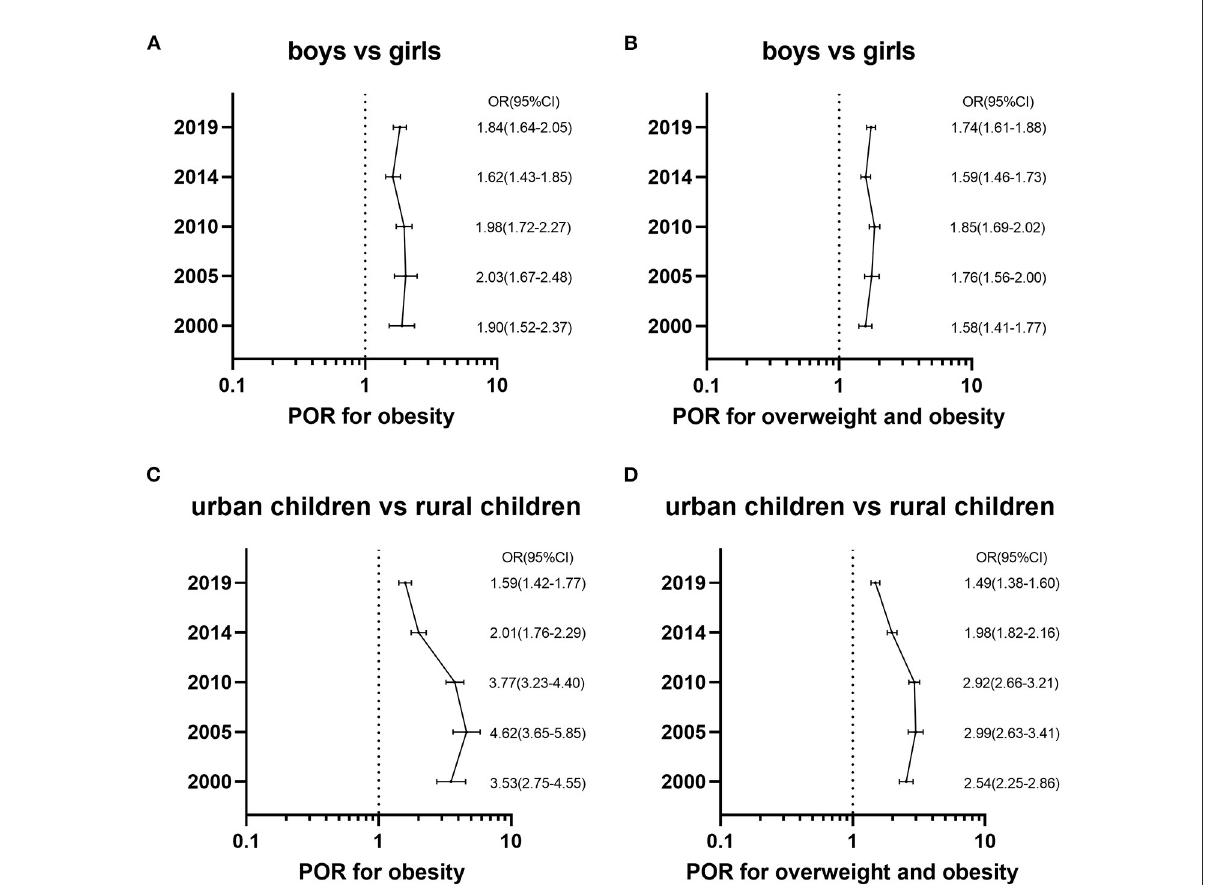
FIGURE3 The prevalence odds ratios (POR) and the 95% confidence intervals (CI) for overweight and obesity of boys vs. girls with adjustment for the region, location and age in different survey years and urban children vs. rural children with adjustment for the region, sex and age in different survey years. (A) Shows PORs for obesity of sex disparity by using WGOC standard. (B) Shows PORs for overweight and obesity combined of sex disparity by using WGOC standard. (C) Shows PORs for obesity of urban-rural disparity by using WGOC standard. (D) Shows PORs for overweight and obesity combined of urban-rural disparity by using WGOC